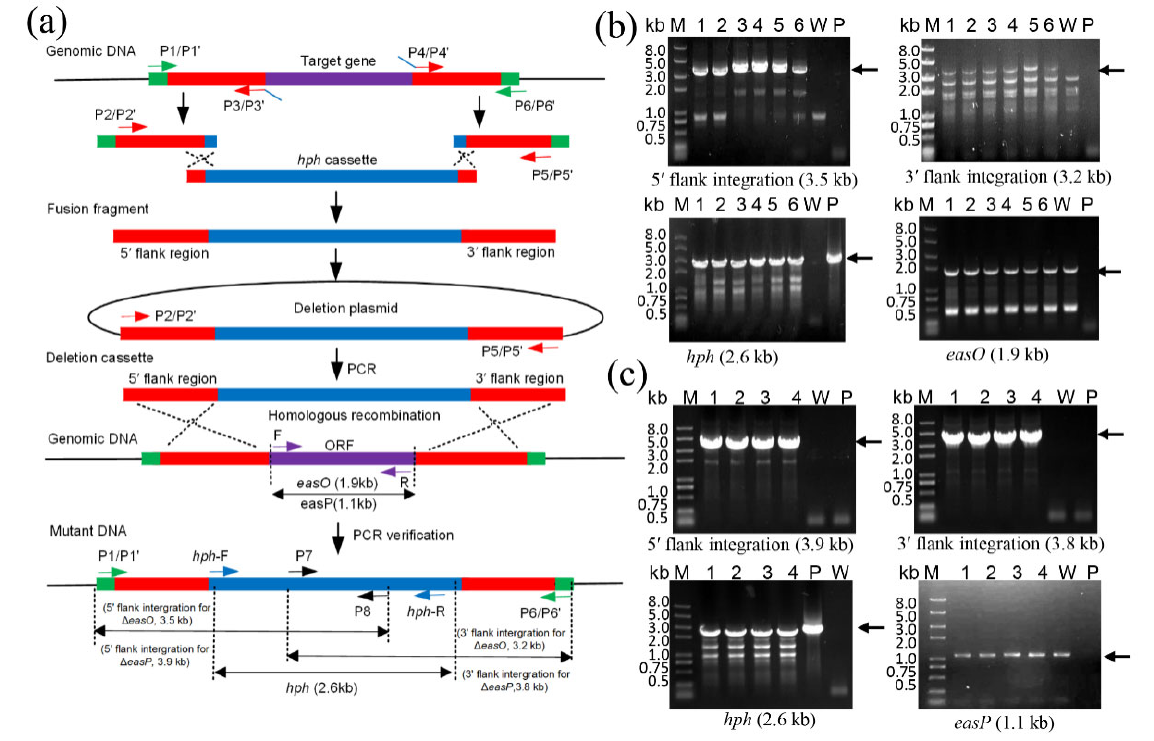
Figure 3. Schematic diagram of the progress of constructing mutant strains and screening of gene knockout mutants. ( a ) Knockout of easO and easP in C. paspali WL721. 5 (cid:48) and 3 (cid:48) flank fragments are amplified separately from genomic DNA with primers P1/P3 and P4/P6 for easO or P1 (cid:48) /P3 (cid:48) and P4 (cid:48) /P6 (cid:48) for easP , respectively. Primers P3 (or P3 (cid:48) ) and P4 (or P4 (cid:48) ) have 5 (cid:48) tails homologous to the hph cassette. The two flanks and the hph cassette are assembled by overlapping PCR method and the fusion fragment containing the deletion cassette is obtained by amplification with primers P2 (or P2 (cid:48) for easP ) and P5 (or P5 (cid:48) for easP ). Homologous recombination creates the circular construct. The deletion cassette harboring the 5 (cid:48) and 3 (cid:48) flank regions of easO or easP was obtained by PCR amplification with primers P2 and P5 for easO or primers P2 (cid:48) and P5 (cid:48) for easP . The fragment harboring the easO or easP in the genomic DNA of C. paspali W721 can be replaced by the deletion cassette containing the hph gene through the double crossover between the deletion cassette and the genomic DNA. The hph is transcribed in the antisense direction relative to the target gene. Transformants carrying the homologous integration of the replacement construct were identified via PCR with primers P1 (or P1 (cid:48) ) and P8, P7 and P6 (or P6 (cid:48) ), respectively. Other pairs of primers were used to conduct PCR verification at the same time: easO -F and easO -R (1900 bp of amplified fragment), hph -F and hph -R (2660 bp of amplified fragment), easP -F and easP -R (1100 bp of amplified fragment). The easP gene was knocked out in the same way as the easO gene. Transformants carrying the homologous integration of the replacement construct were identified via PCR with two different pairs of primers P1 (cid:48) and P8, P6 (cid:48) and P7, respectively. Two additional pairs of primers, easP -F and easP -R (1100 bp of amplified fragment), hph -F and hph -R (2660 bp of amplified fragment), were used to conduct PCR verification. ( b ) Screening of ∆ easO transformants via PCR. M: DNA marker. 1–6: ∆ easO transformants. ( c ) Screening of ∆ easP transformants via PCR. M: DNA marker. 1–4: ∆ easP transformants. W: C. paspali WL721 wild strain. P: pAN7-1